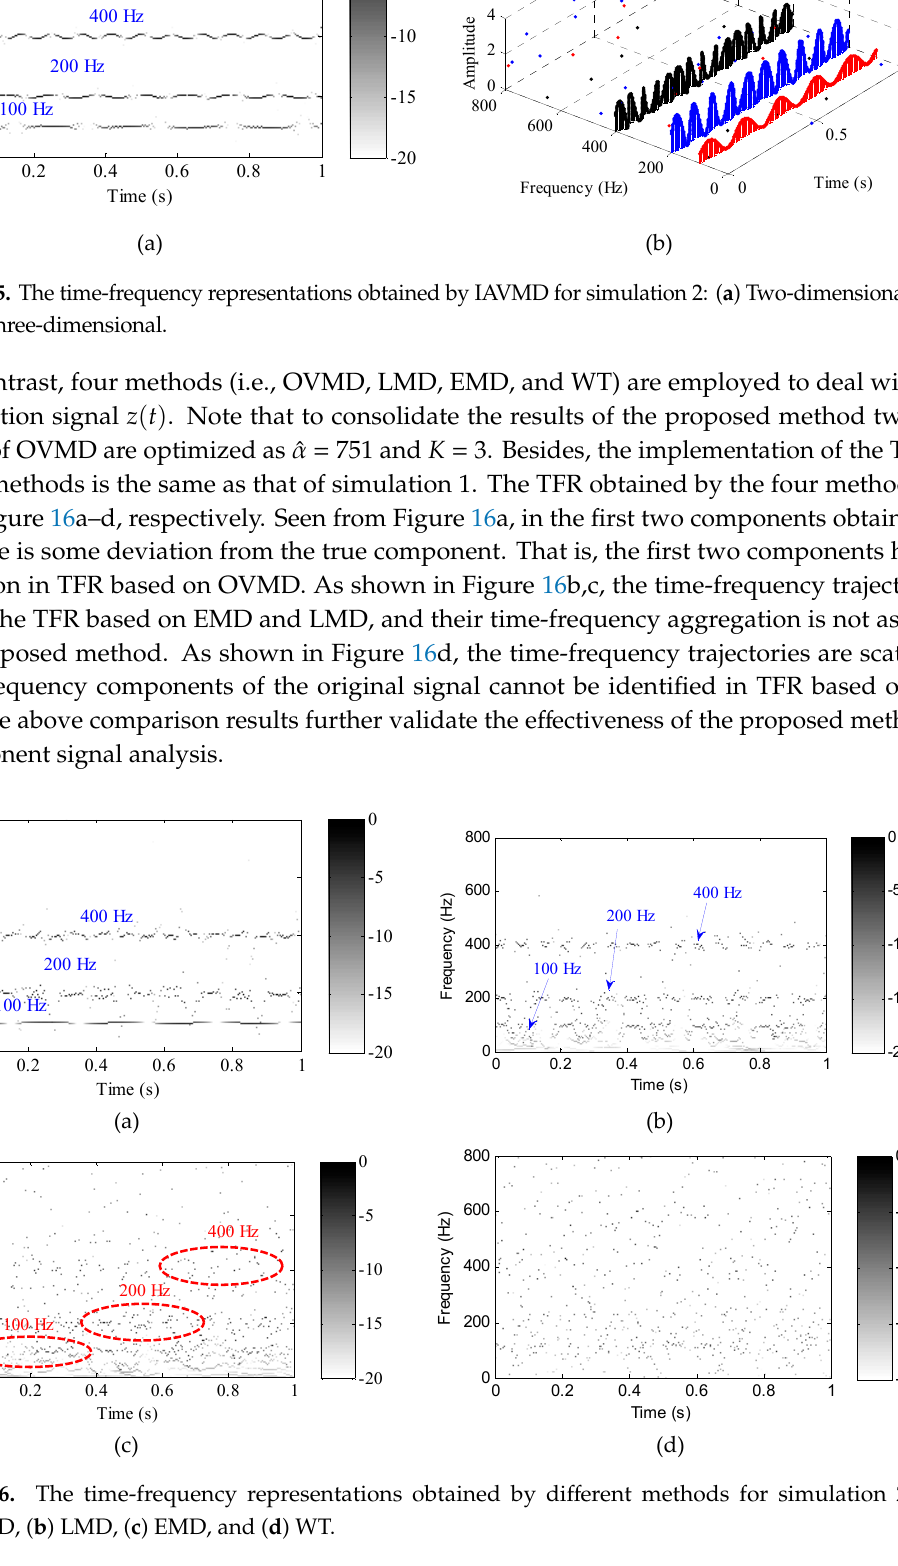
OVMD, ( b ) LMD, ( c ) EMD, and ( d ) WT.